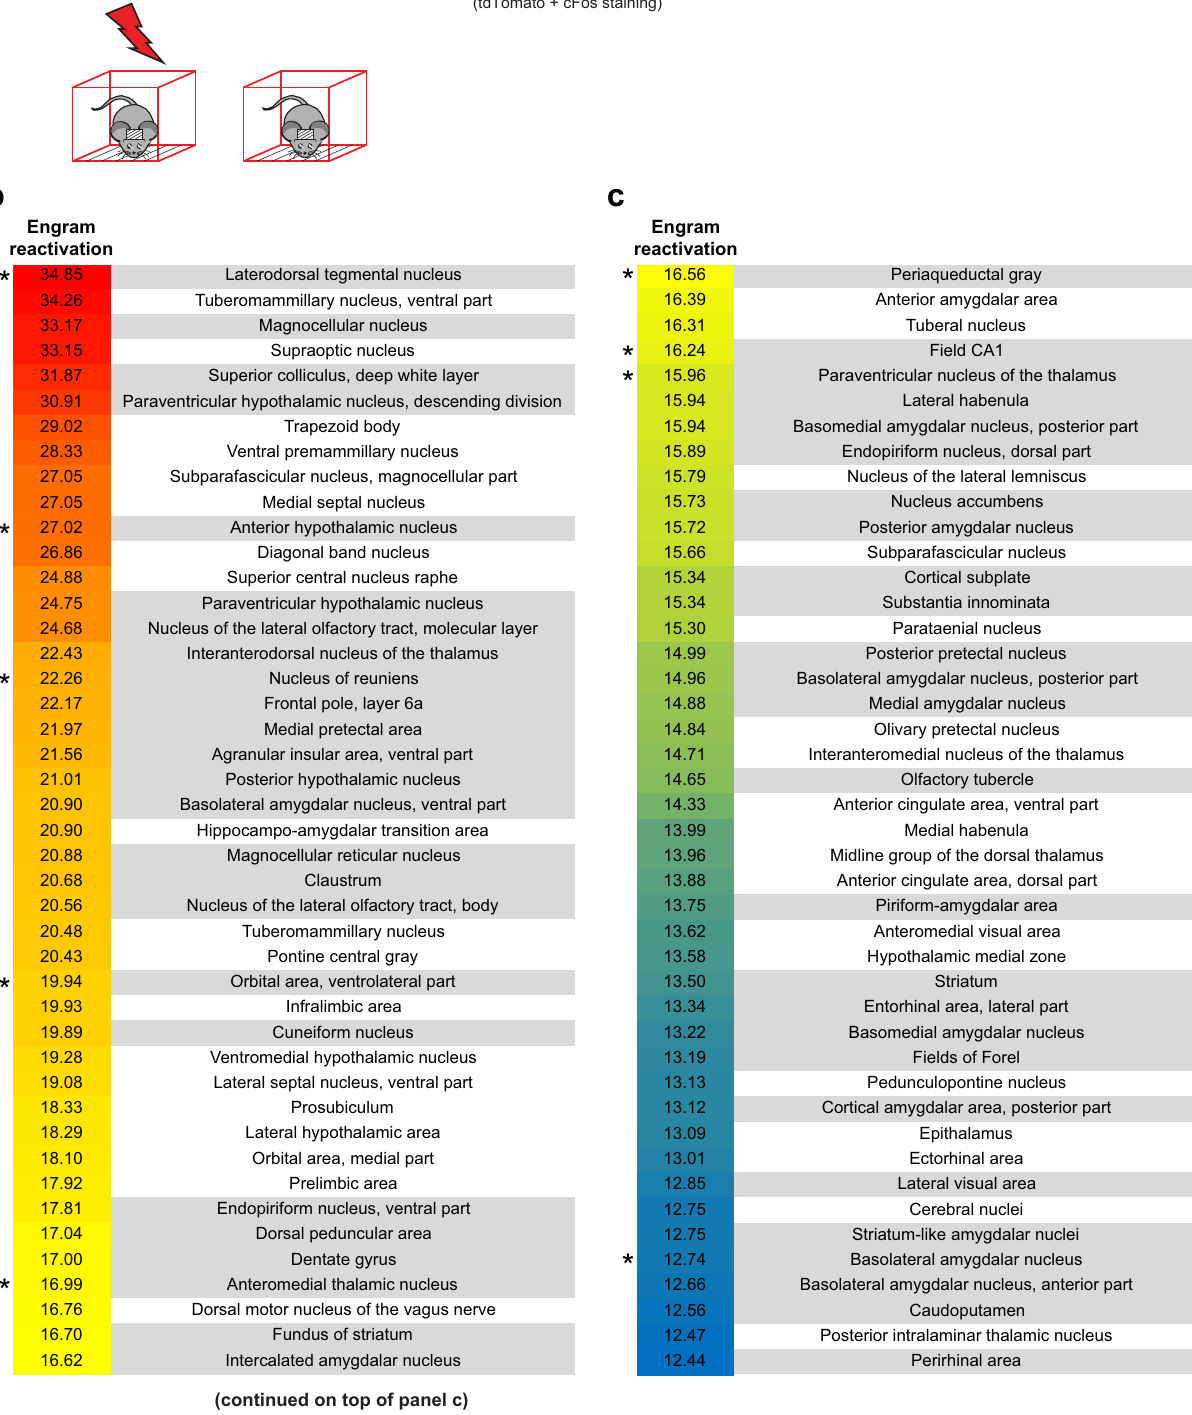
Fig. 3 Brain-wide engram reactivation. a To identify CFC activated neurons that are reactivated by recall (i.e., exhibiting overlap), activated neurons during CFC were labeled using 4-OHT on day 1 and three days later activated neurons during recall were labeled using cFos staining. b , c Rank-ordered list of 88 brain regions with their engram reactivation values (percentage of CFC activated neurons that subsequently showed recall-induced cFos) that passed our statistical criteria ( n = 9 CFC mice). For a list of 159 non-signi fi cant brain regions based on our statistical criteria, refer to Supplementary Table 3. Regions highlighted in gray are consistent with those identi fi ed by the brain-wide engram index analysis in Fig. 2. Regions with an asterisk were tested in the optogenetic engram reactivation behavioral experiments described in Fig.